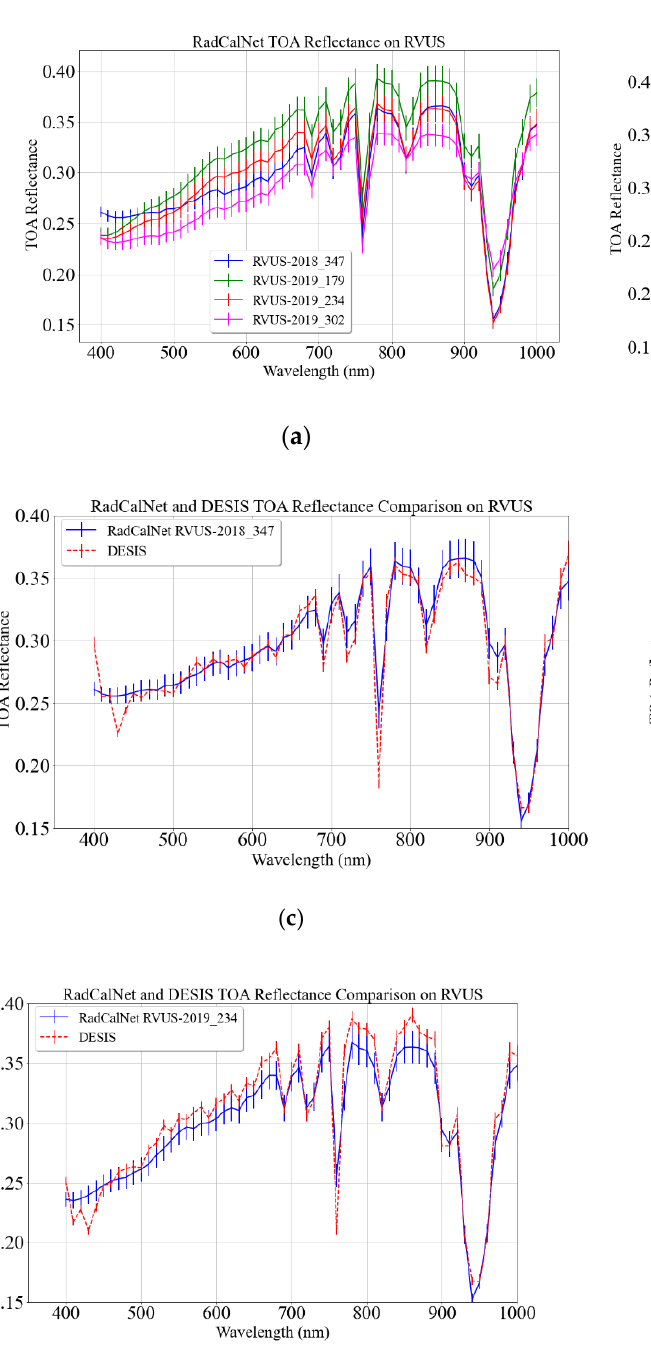
9 of 26 Figure 5. Acquisition geometry on RVUS. Blue symbols represent DESIS viewing geometry, red symbols represent DESIS solar geometry, and black symbols represent RadCalNet solar geometry. Figure 6a shows RVUS TOA reflectance using RadCalNet with 1-sigma standard de- viation. The standard deviation represents the associated uncertainty with the spectrum provided by RadCalNet technical working group [20] which is approximately 4% for all spectra shown in Figure 6a. The variation in TOA reflectance is due to seasonal variation as these spectra are acquired at different times of the year. The sharp decrease in TOA reflectance at approximately 760 nm and 940 nm is because of absorption due to water vapor. Results at these channels are unreliable due to the combined effects from low signal from both systems and high sensitivity to atmospheric characterization [5]. Similarly, Figure 6b shows DESIS TOA reflectance on RVUS with 1-sigma standard deviation. The associated standard deviation represents the spatial variation of the se-